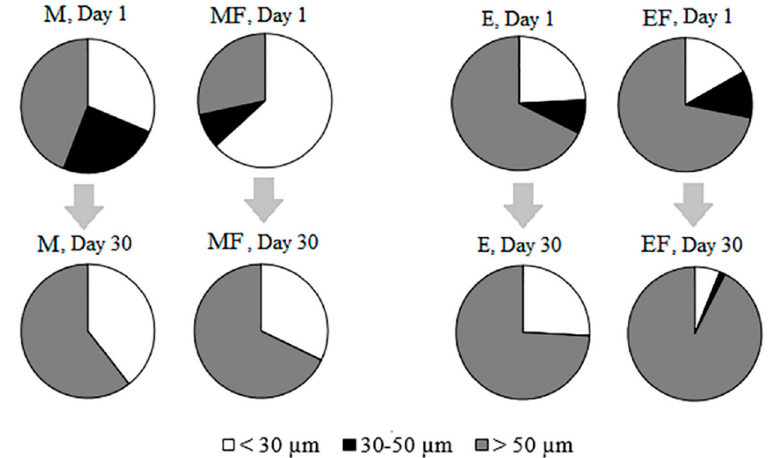
Figure 6. Size structure of phytoplankton on Day 1 and Day 30 in M—mesotrophic conditions, MF— mesotrophic conditions with introduced fish, E—eutrophic conditions, EF—eutrophic conditions with introduced fish.